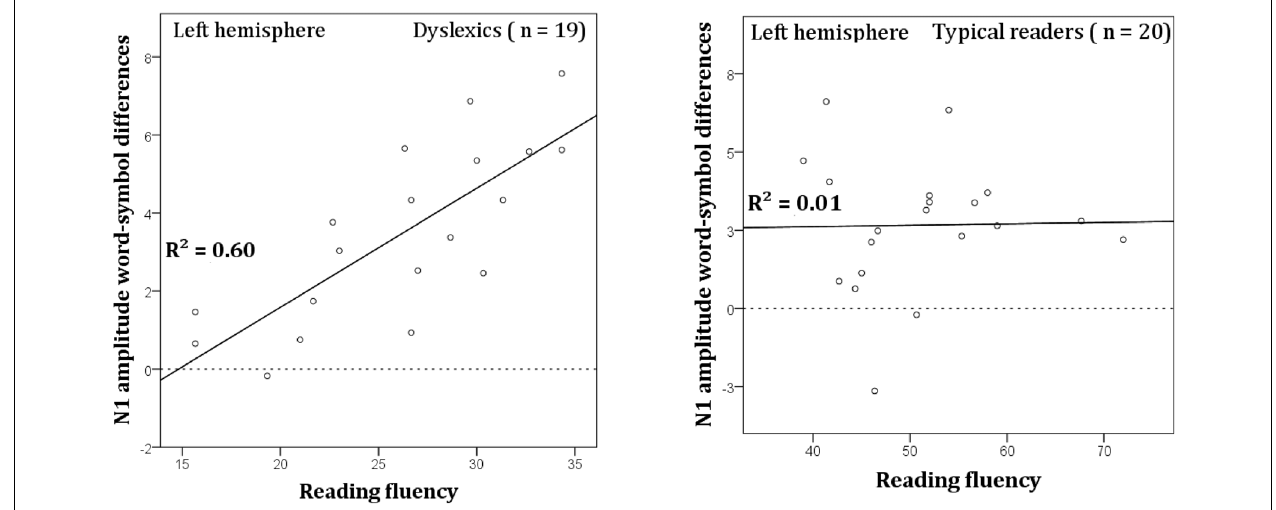
FIGURE 8 | Correlation between N1 word-symbol amplitudes averaged across the left hemisphere sitesTP7, P9, P7, P5, PO7, PO3, and O1, and the composite reading fluency scores for dyslexic (left) and typical readers (right).